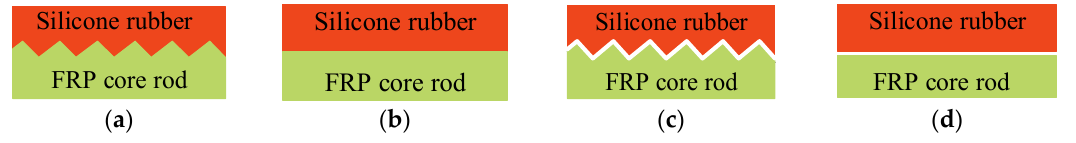
Figure 12. Interface of different performance caused by different production process: ( a ) YY1~YY3;